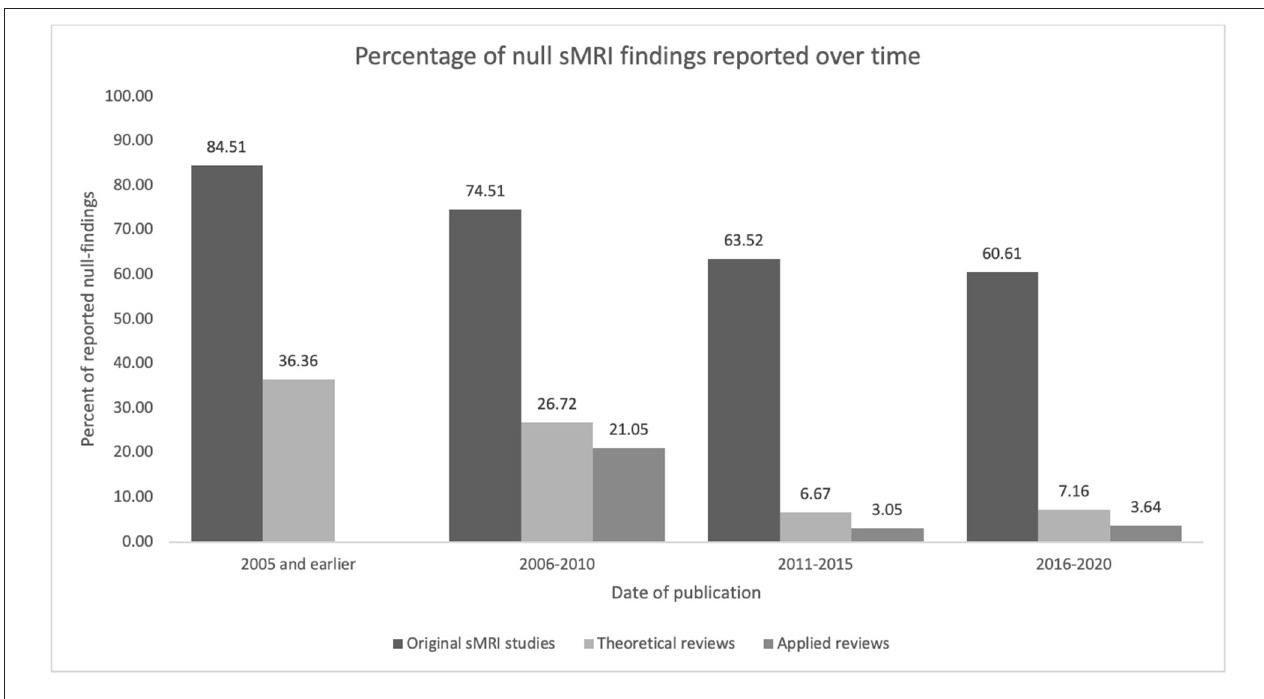
FIGURE 2 | Null sMRI findings reported over time.